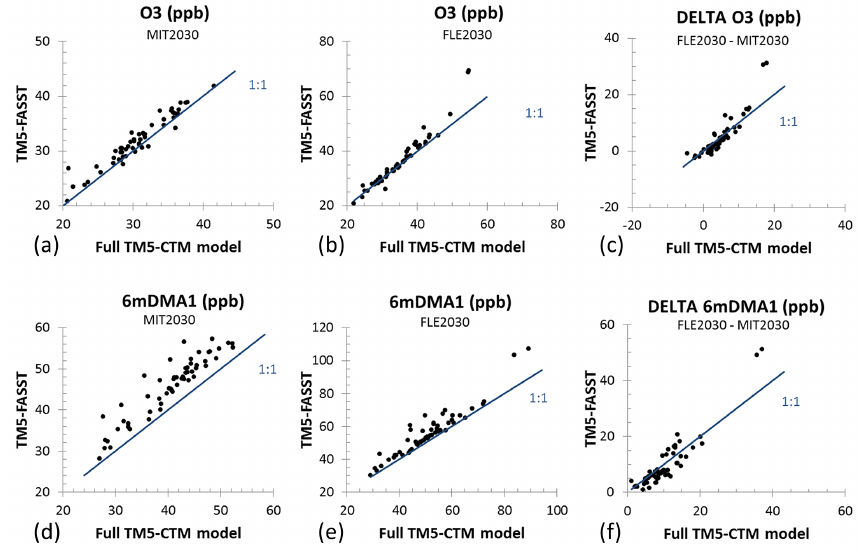
Figure 10. Population-weighted mean annual ozone (a–c) and ozone exposure metric 6mDMA1 (d–f) computed with TM5-FASST versus TM5 CTM for low-emission scenario MIT2030 (a, d) , high-emission scenario FLE2030 (b, e) , and the change between the two (c, f) . Each point represents the population-weighted mean over a TM5-FASST receptor region. The blue line is the 1 : 1 relation.